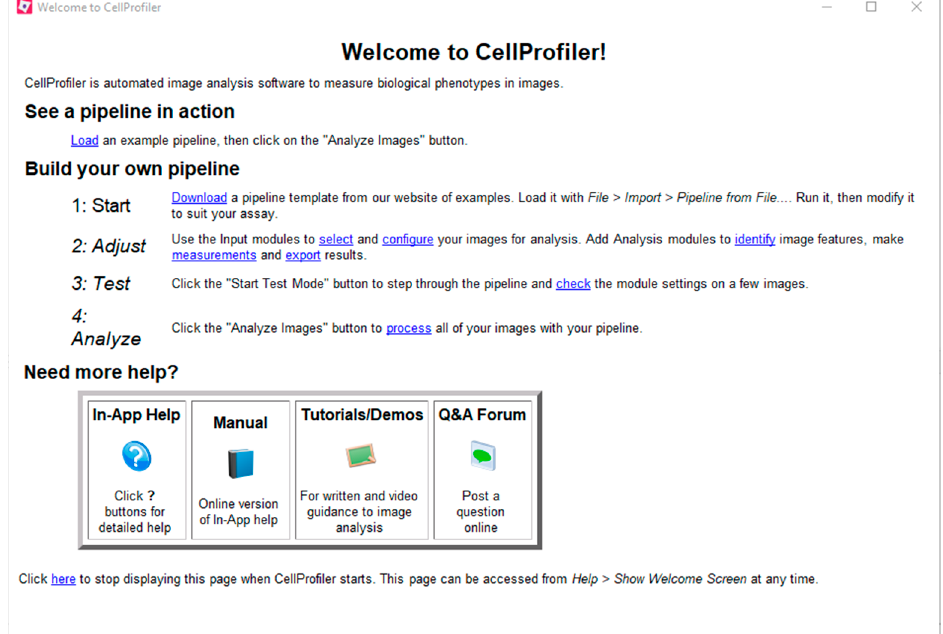
Figure 1. Welcome Screen of CellProfiler™ v.3.1.9 shows the options to see examples of pipelines or create a new one with help and tutorials.